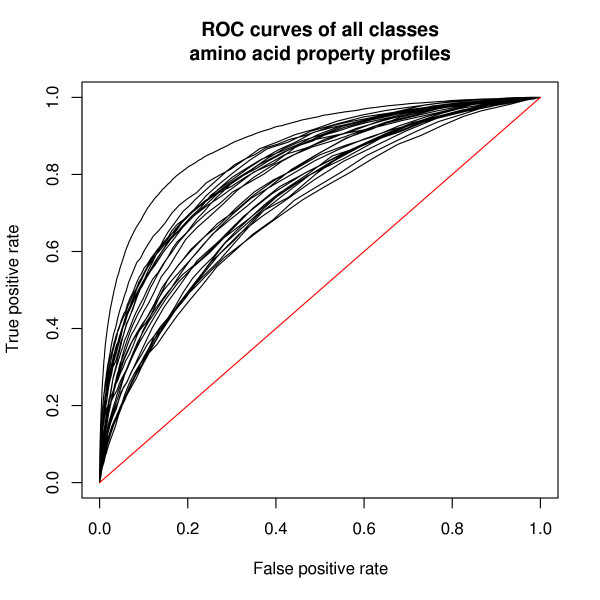
ROC curves for the 27 structural classes (using physico-chemical property profiles and RF classifier).